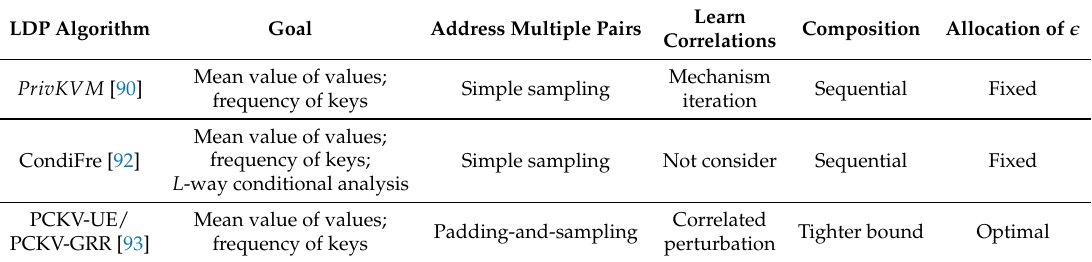
Table 7. Comparisons of LDP-based protocols for frequency/mean estimation on key-value